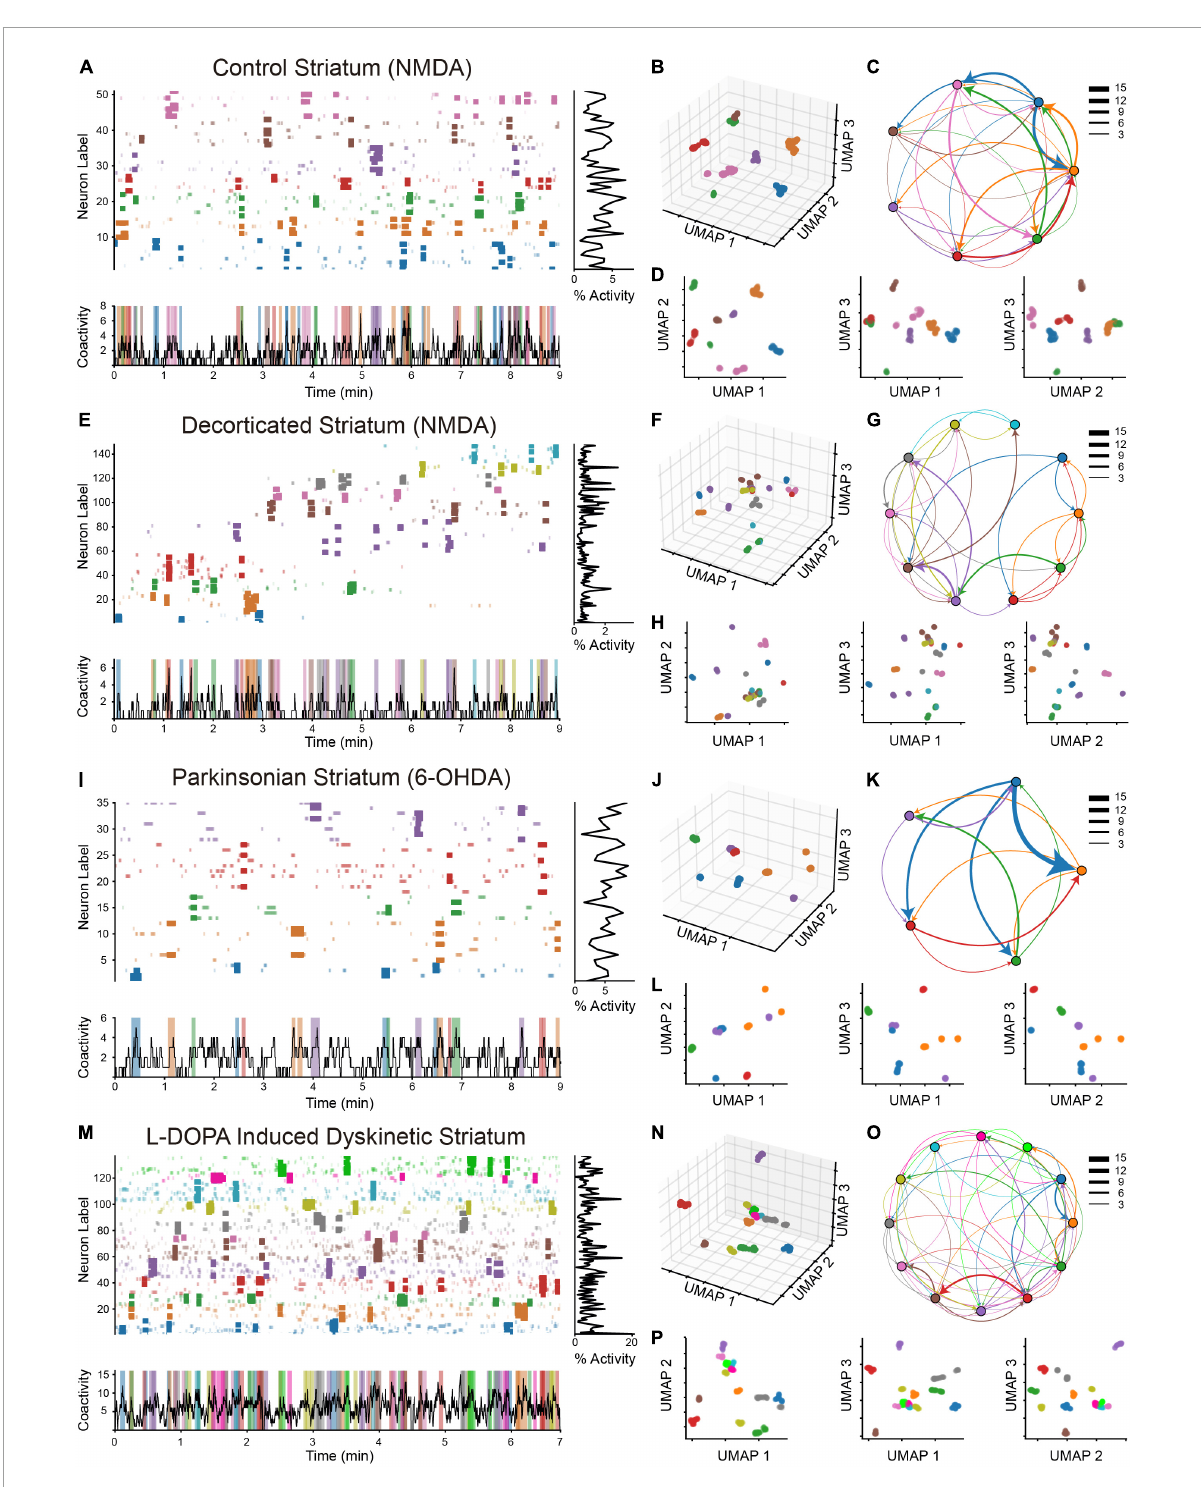
FIGURE5 Dynamics of neuronal ensembles in different experimental conditions. (A) Significant activity of neuronal ensembles was identified in a raster plot obtained in the striatum under the control condition in the presence of N-methyl-D-aspartate (NMDA) to pharmacologically evoke the activation of network components; this brain nucleus is commonly very silent when there is no stimulus (spontaneous firing: Lara-González et al., 2019). The coactivation peaks are shown by darker colors, while the coactivation peaks that are not significant are indicated by paler colors for the same ensembles of neurons. (B) A low-dimensional UMAP projection of the significant peaks of coactivity ( V P ) that identify the significant coactive matrices from the raster plot. The colors denote identified neuronal ensembles, each in a specific niche in the UMAP